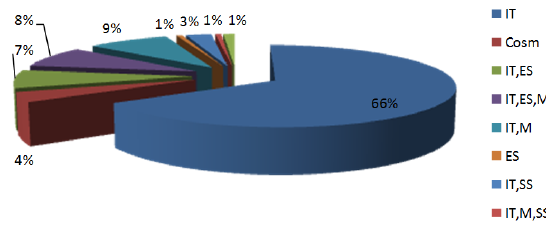
Fig. 5. Percentage of geographical distribution of plants growing regions in Kaseh-Garan area, Gilaneghaeb county: IT) Irano-Turanian; Es) Europe- Siberia; M) Mediterranean; SS) Sahara-Sandy; Cosm)